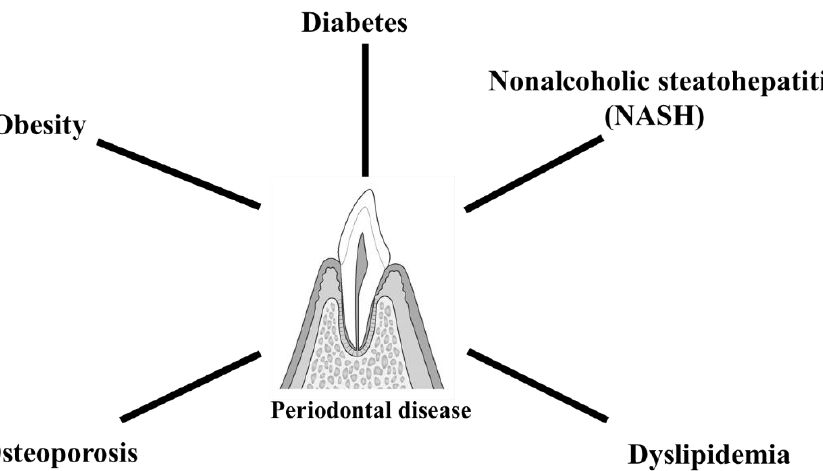
Figure 2. Relationship between periodontal disease and metabolic diseases. Metabolic disease groups that have been reported to be associated with periodontal disease include diabetes, obesity, nonalcoholic steatohepatitis (NASH), dyslipidemia, and osteoporosis.